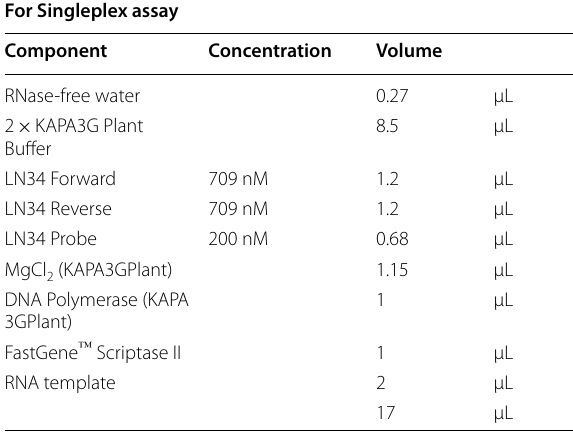
Table 1 Components of mixture for rabies PCR1100 assay For Singleplex assay